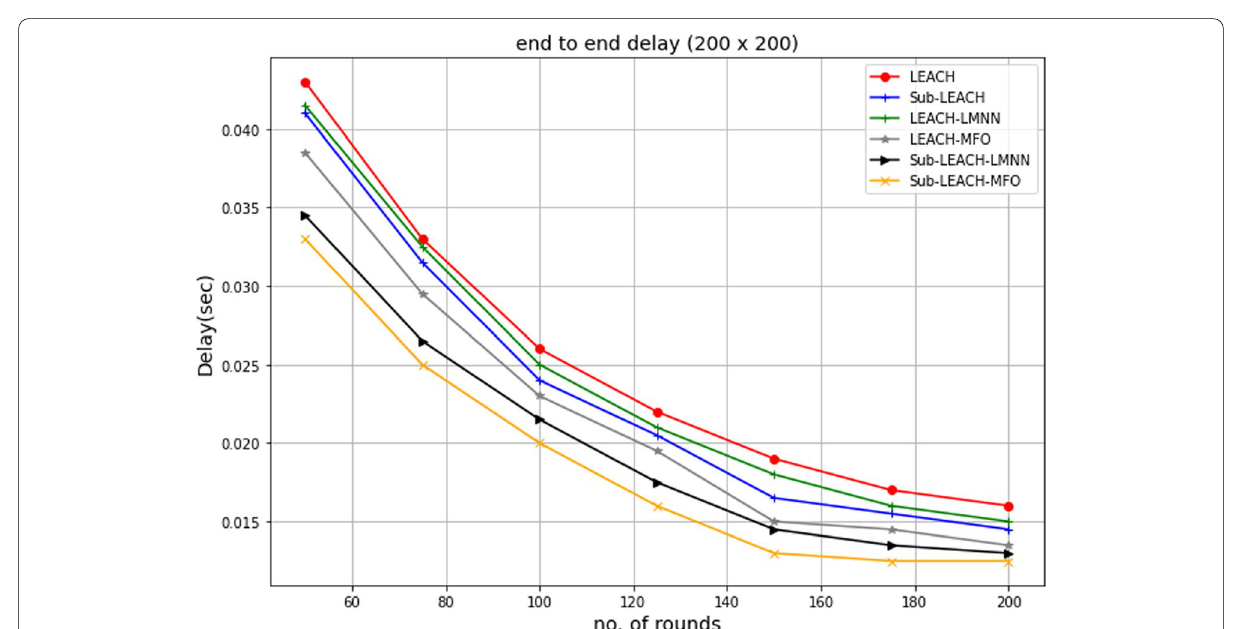
Fig. 12 Graphical representation of delay for